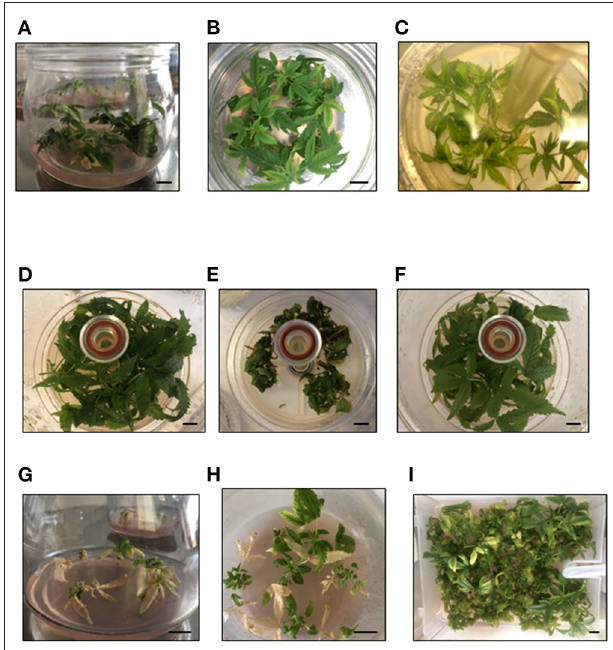
FIGURE 1 | Mati (A) and Beatriz (B) genotypes cultured in β -A semi-solid medium with 2% sucrose. Beatriz genotype cultured in RITA ® with MS ½ N with 2% sucrose (C) , β - A with 2% sucrose (D) , MS– ½ N with 0.5% sucrose (E) , and β -A with 0.5% sucrose (F) . Mati (G) and Beatriz (H) genotypes cultured in β -A semi-solid medium with 0.5% sucrose, Beatriz genotype (I) cultured in Plantform TM with β -A medium and 0.5% sucrose. Bars,